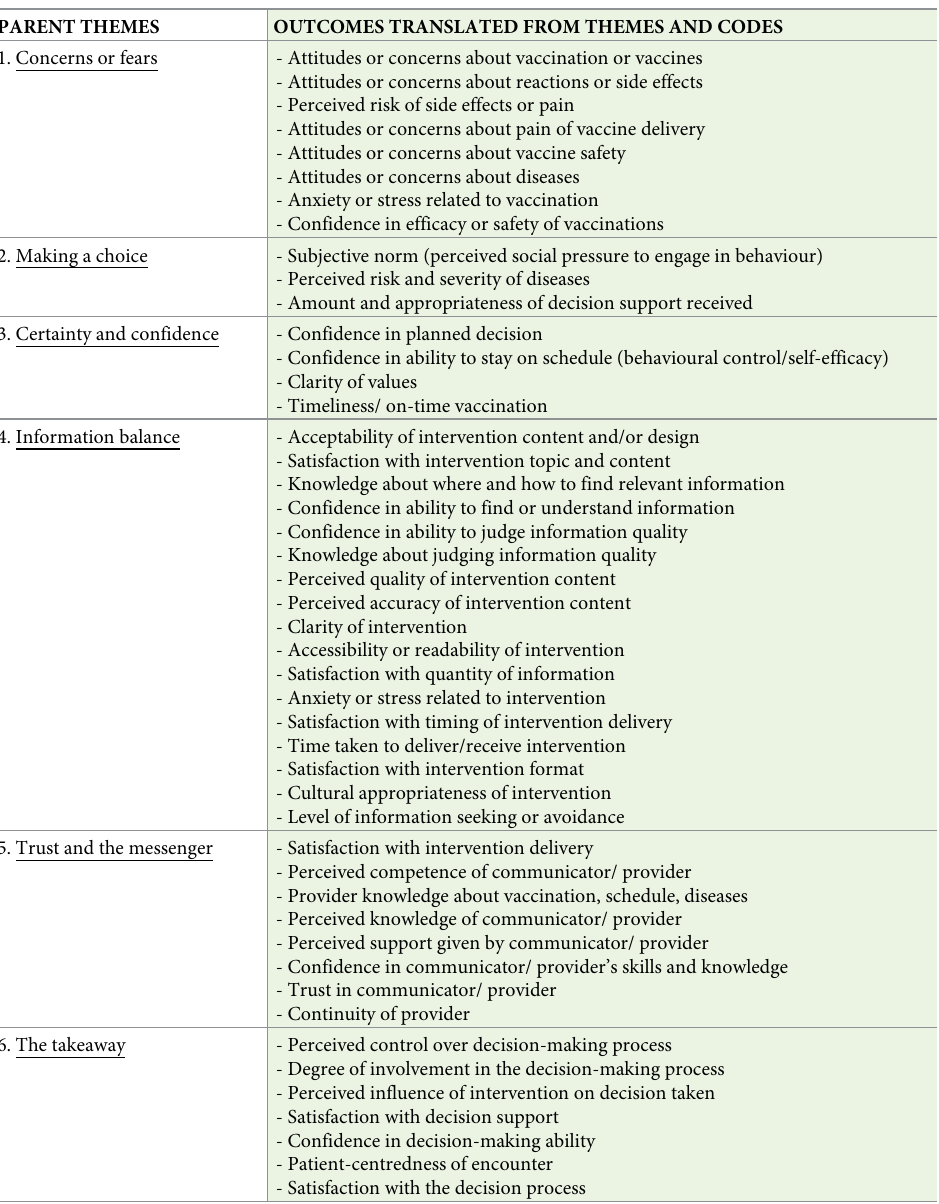
Table 2. Parent themes and translated